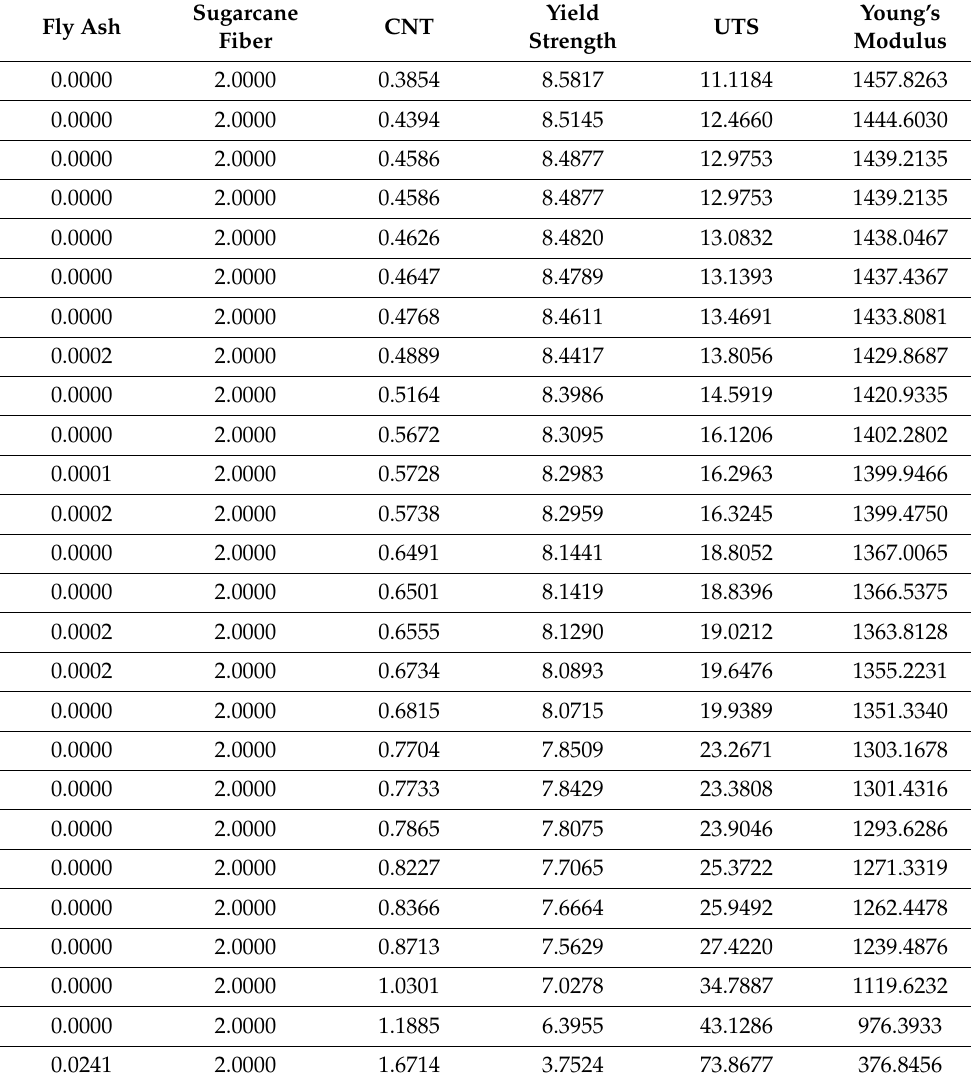
Table 2. Optimizing the objectives {YS, UTS, YM} without any constraints imposed on input parame- ters {fly ash, SCF,